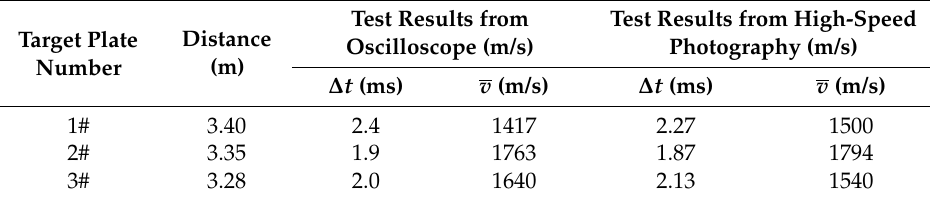
Table 3. Fragment velocity of D-90 ◦ experiment.